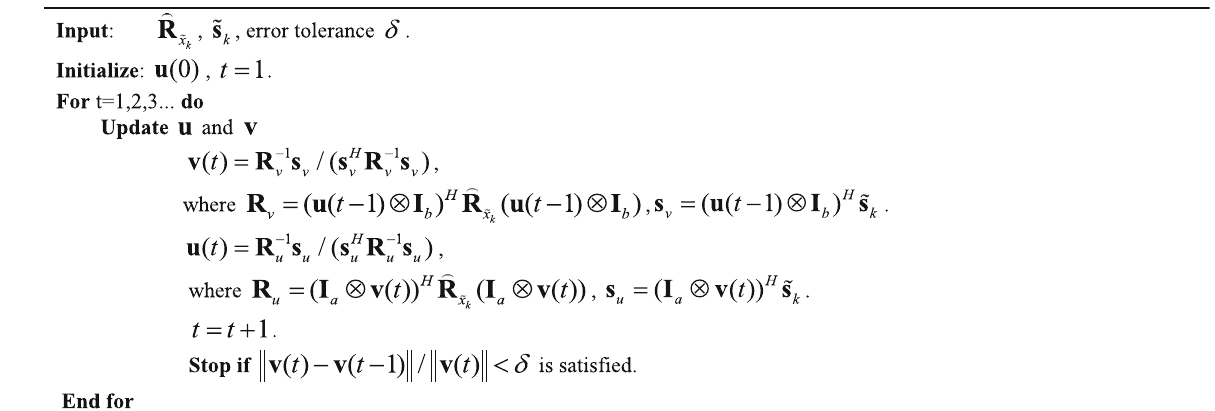
Table 1 Bi-iterative